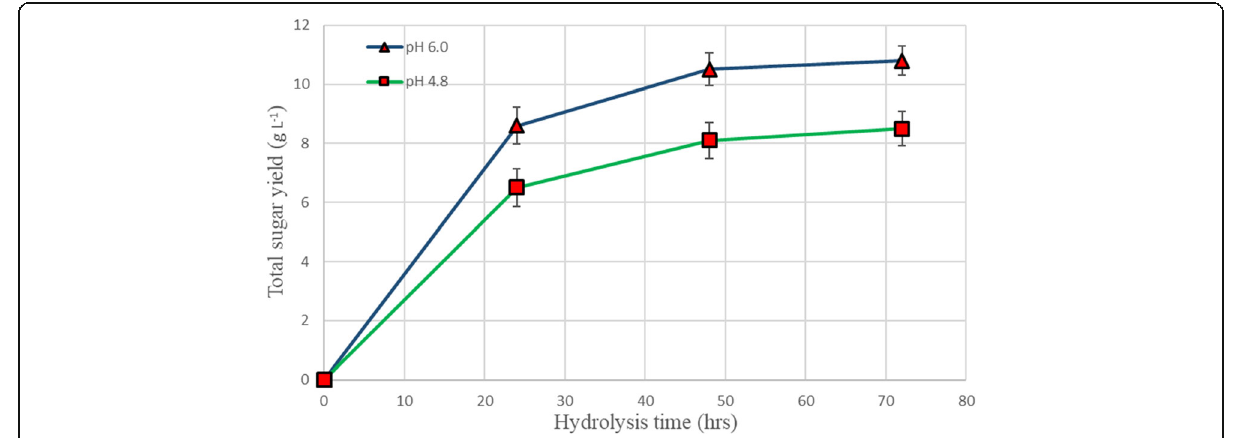
Fig. 7 Total reduced sugar yield at the end of hydrolysis (72 h) for pH 4.8 and